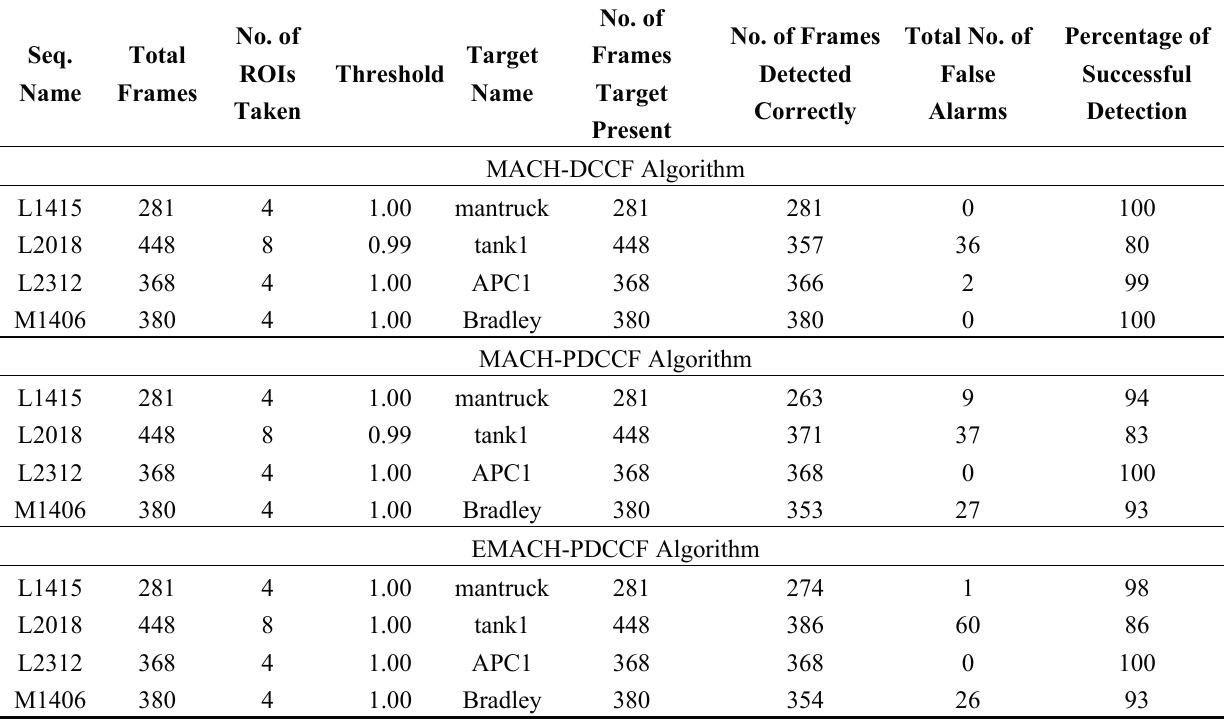
Table 5. Tracking results of single-target